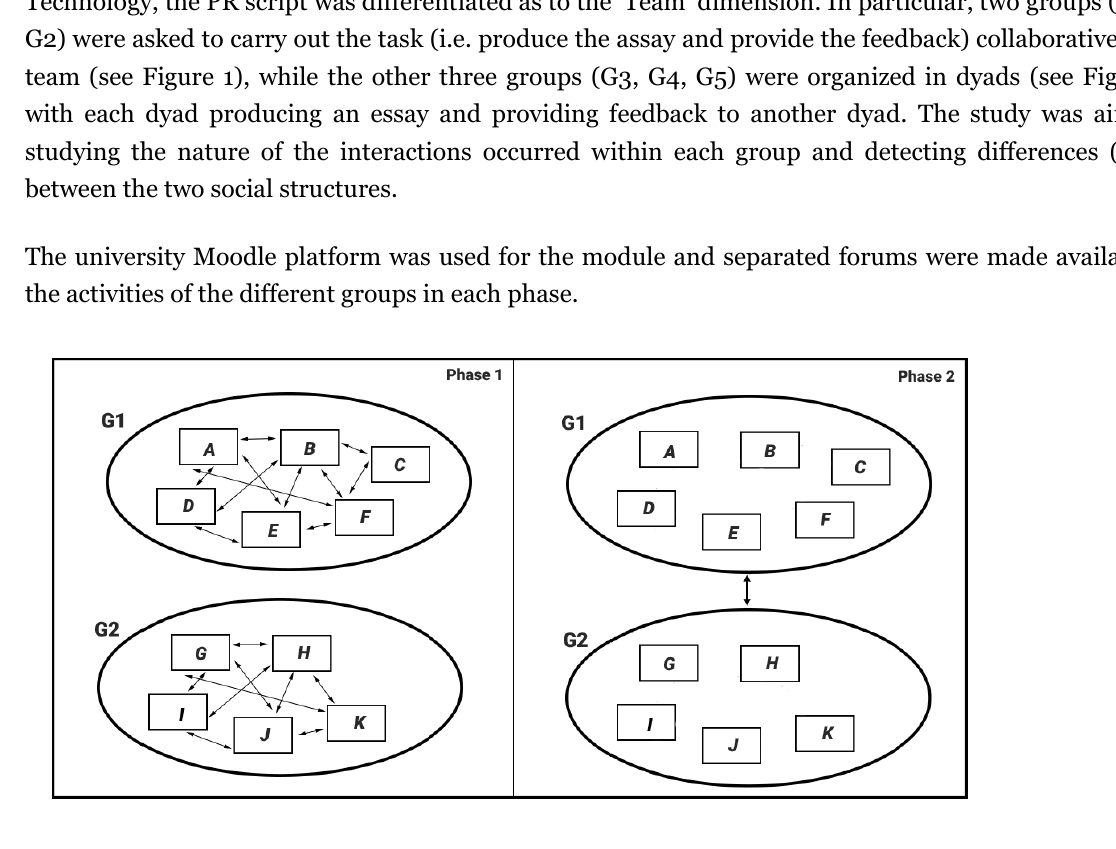
Figure 1. PR in group (G1,